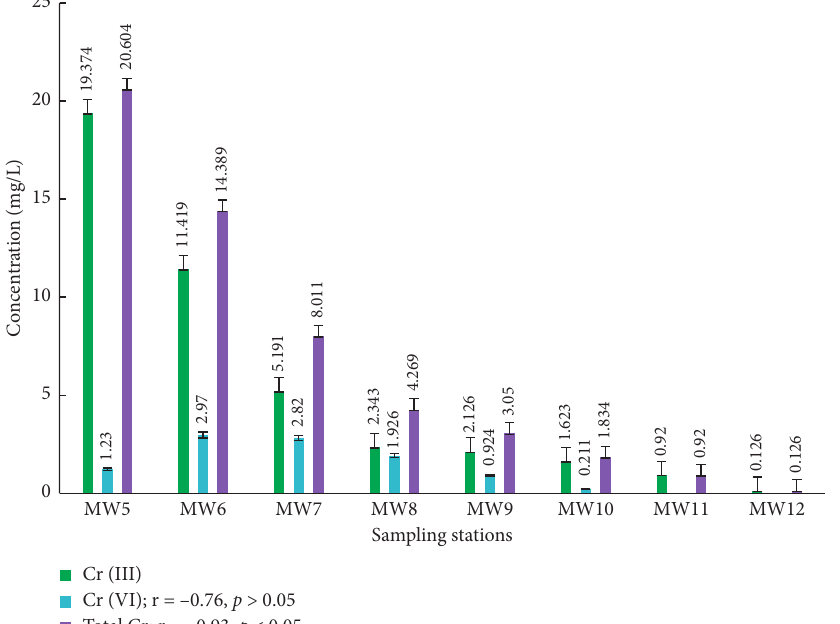
Figure 2: Concentration and species of chromium at Modjo River below the discharge point of Colba tannery, Modjo, Ethiopia (MW � Modjo River water sample). Table 2: Concentration and species of chromium in soil between the wastewater treatment plant of Colba tannery and the receiving river